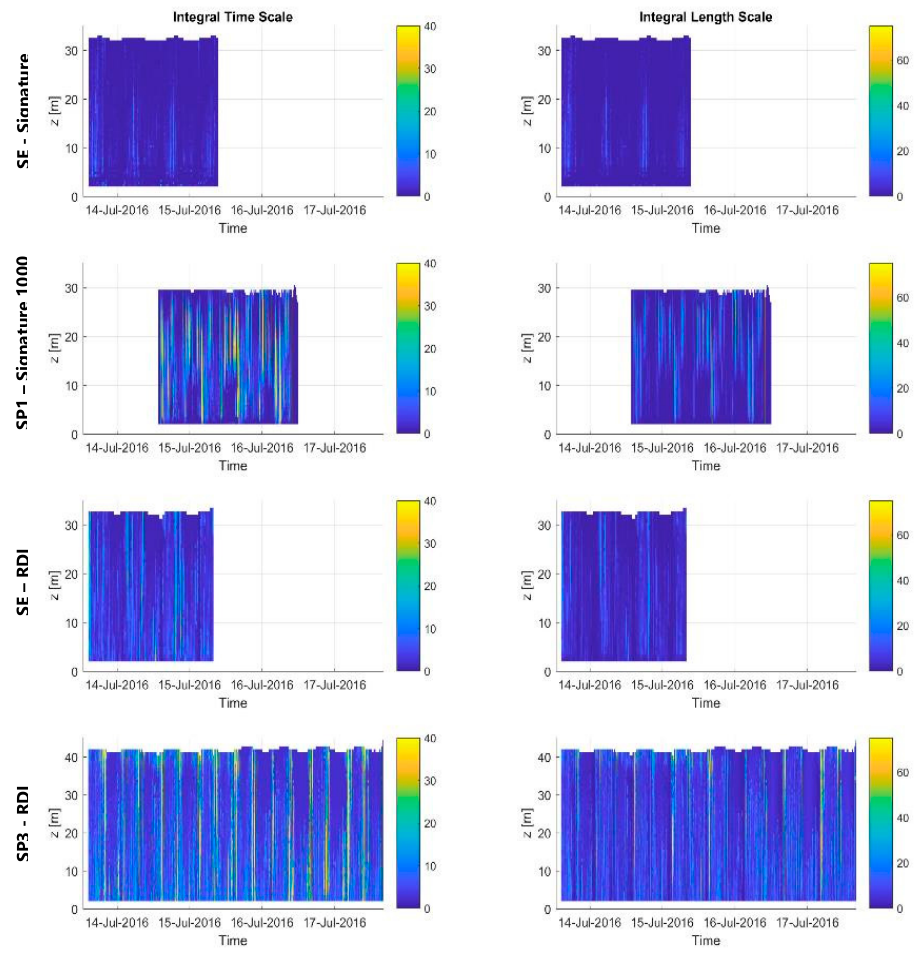
Figure 10. The time (left) and length (right) integral scales presented in time and water depth for all sensors. Colour scale units are presented in seconds for the left column of subplots and meters for the right column of subplots.